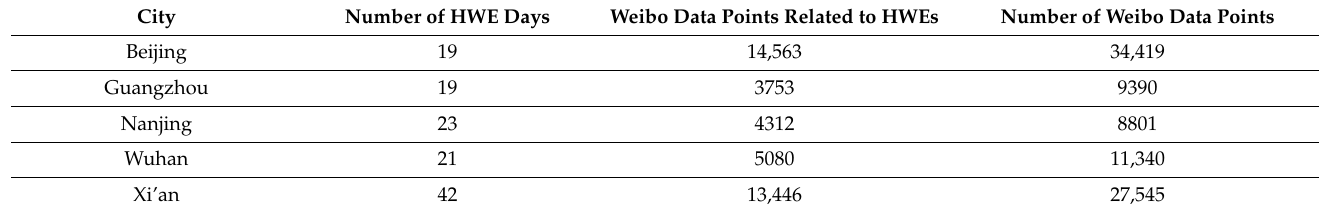
Table 2. Number of HWE days and corresponding Weibo data points in five